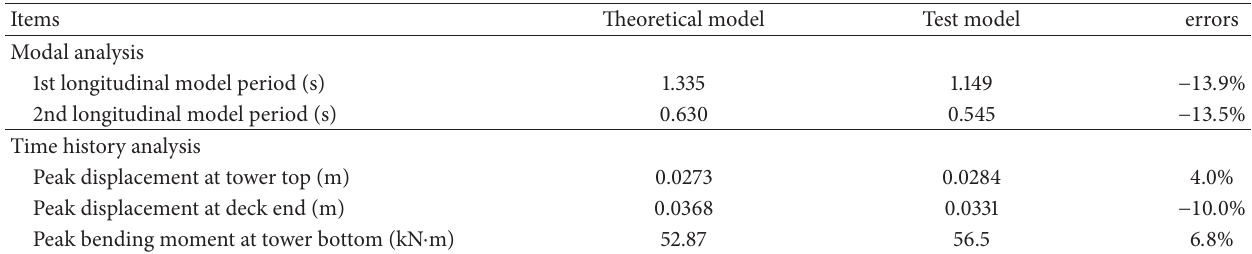
Table 5: Comparison of the test model and theoretical model.